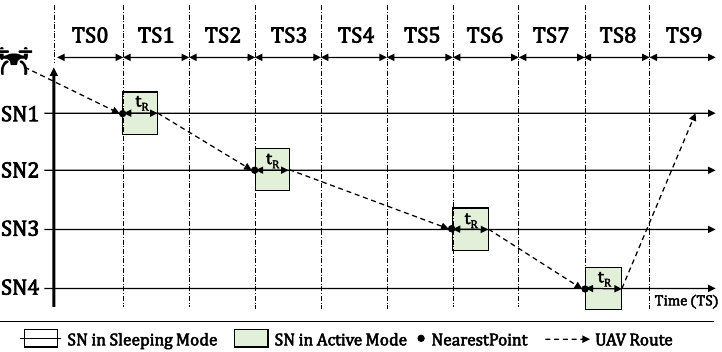
Figure 6. SN activation timeslot scheduled according to the UAV